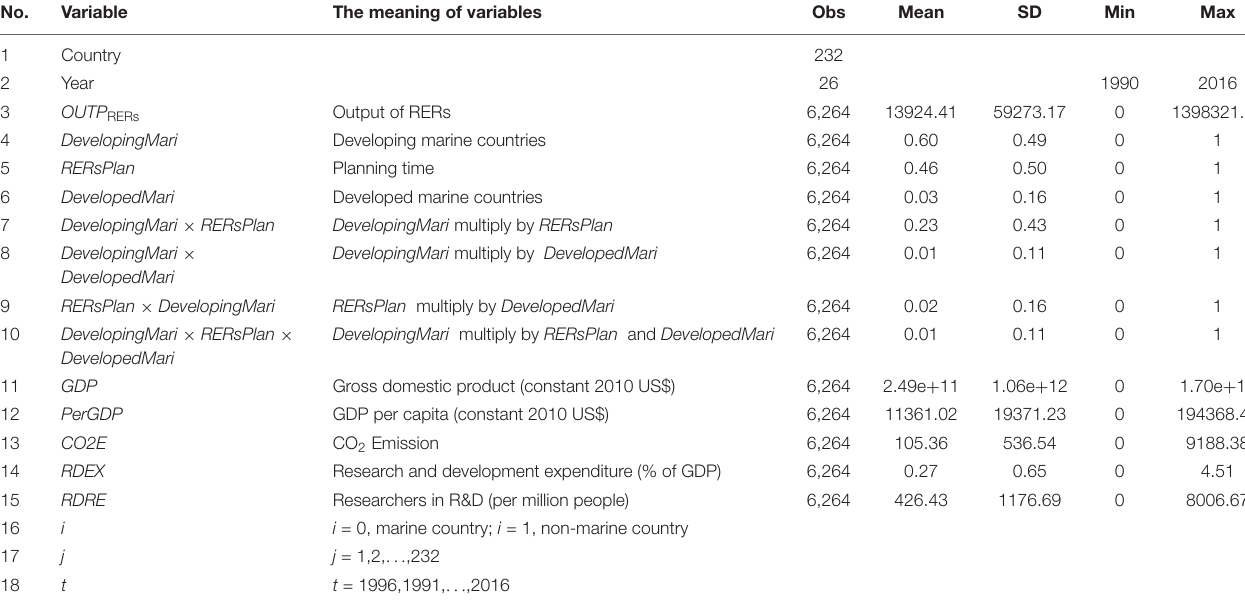
TABLE 1 | Variables of the DDD model and associated descriptive statistics.